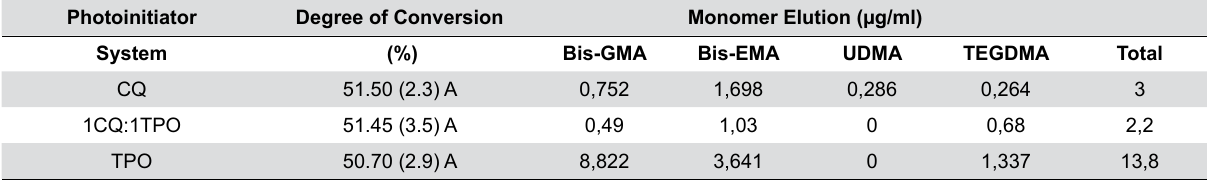
*Different letters indicate statistically significant difference in between rows.